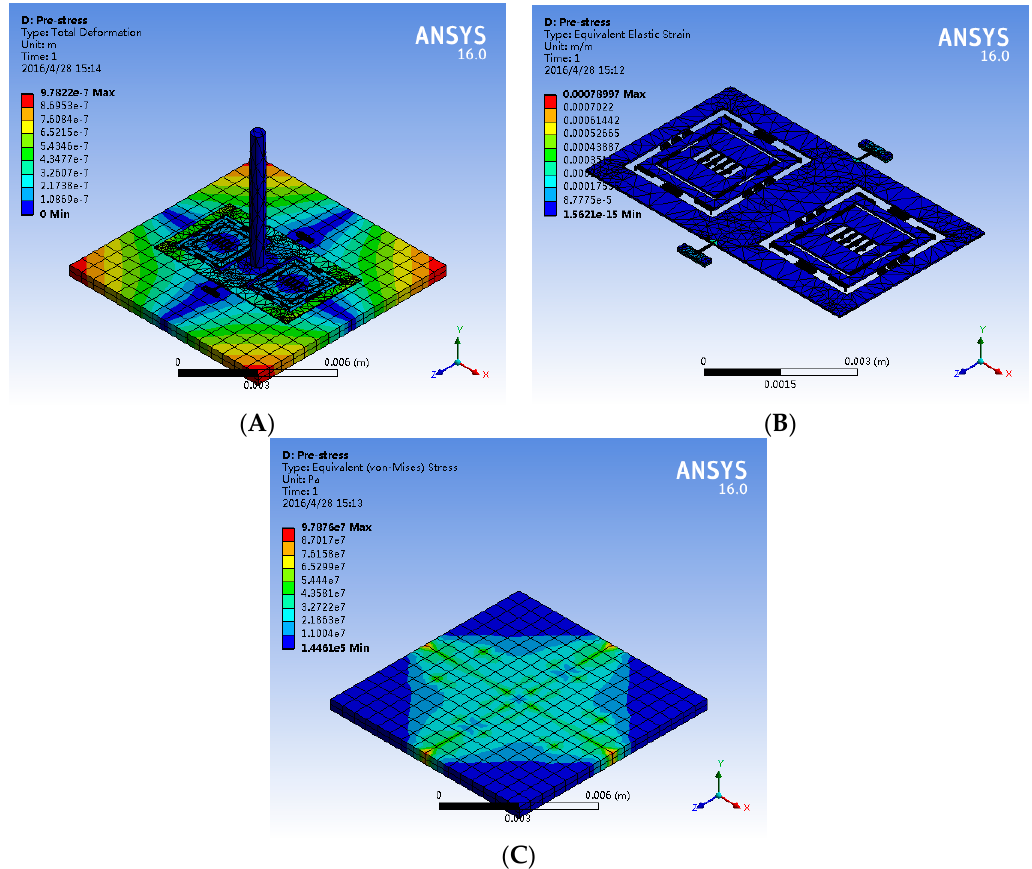
Figure 12. The deformation and stress distribution of hair sensor at 80 °C. ( A ) The deformation of the hair sensor; ( B ) The stress distribution of the silicon structures; ( C ) The stress distribution of the substrate.